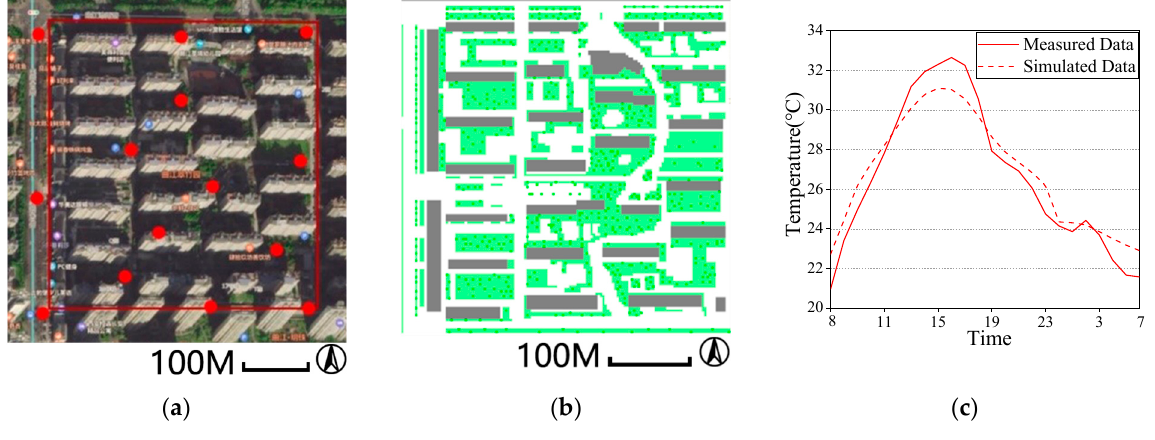
Figure 3. ( a ) Scope of Qujiang Cuizhu District and measuring points; ( b ) ENVI-met model of Qujiang Cuizhu District; and ( c ) the changes in measured and simulated temperatures in pedestrian height over time .